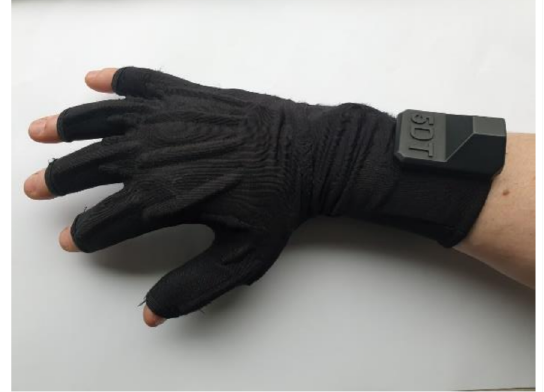
Figure 24. Fifth Dimensions–5DT smart glove.